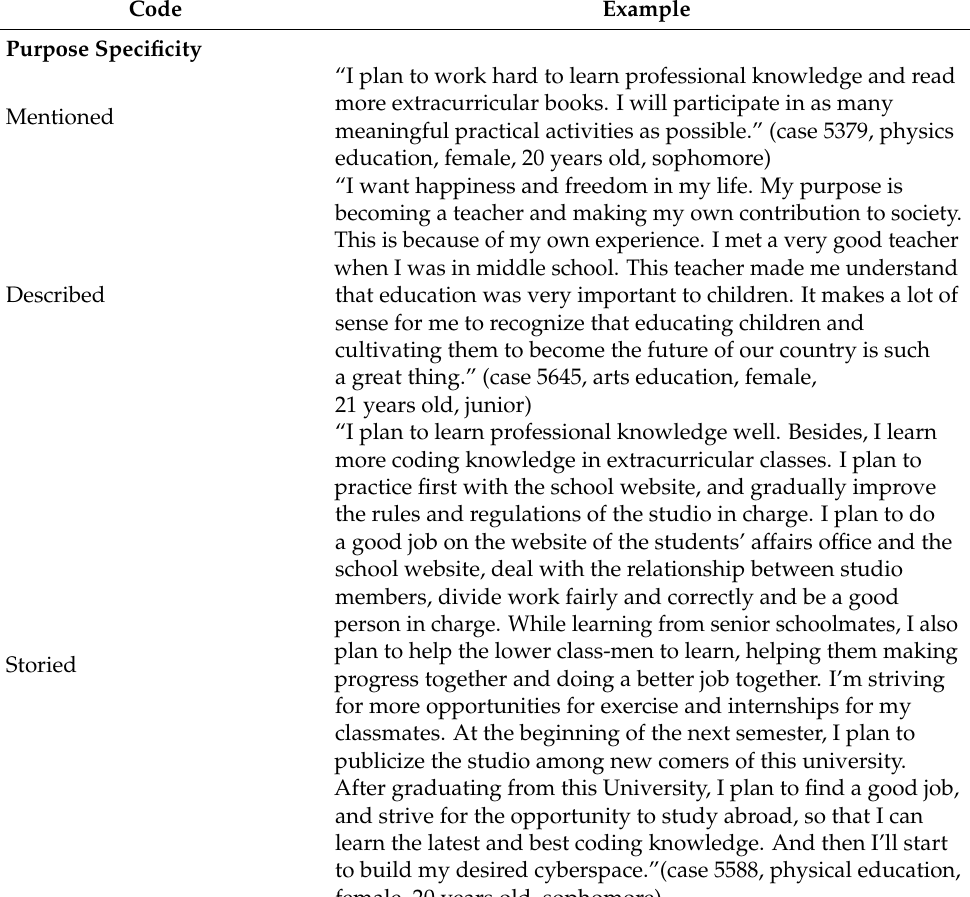
Table 1. Examples of statements coded for purpose specificity and